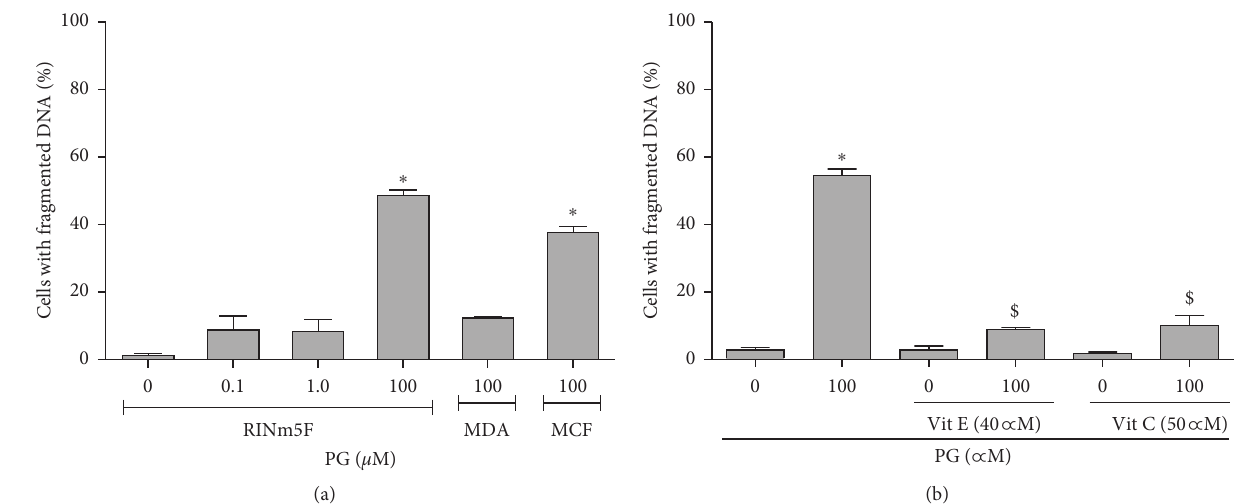
Figure 2: DNA fragmentation in progesterone-treated cells. (a) RINm5Fcells incubated with absolute ethanol (control) or 0.1, 1.0, and 100 μ M progesterone by 24h. (b) Cells were preincubated with 40 μ M vitamin E or 50 μ M vitamin C for 2h and then with absolute ethanol (control) or 100 μ M progesterone for 24h. 10,000 events were analyzed, by flow cytometry, per sample. Data are presented as means ± SEM of three experiments in duplicates. ∗ indicates difference in comparison to control. $ indicates difference between preincubation with the vitamins and the treatment with only 100 μ M progesterone ( ρ < 0.05). PG: progesterone; Vit E: vitamin E; Vit C: vitamin